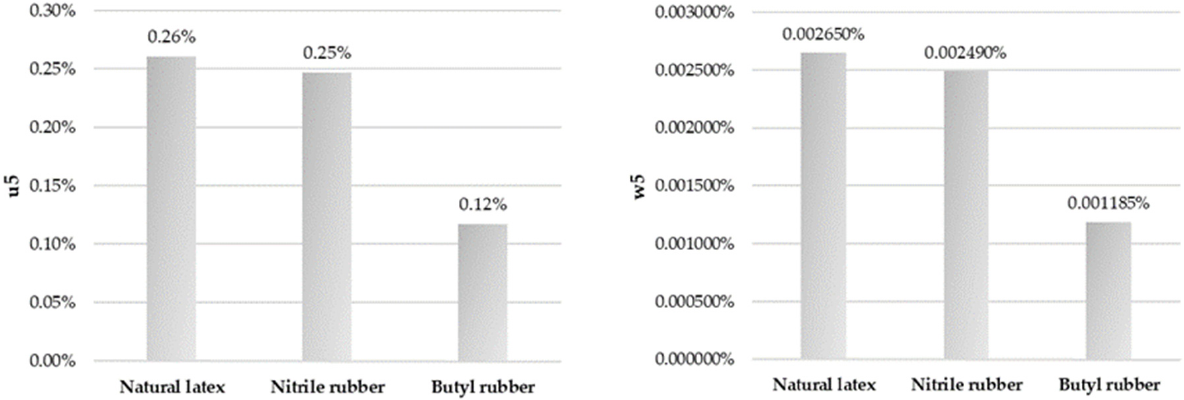
Figure 5. Relative uncertainty of the components of the performed measurements.